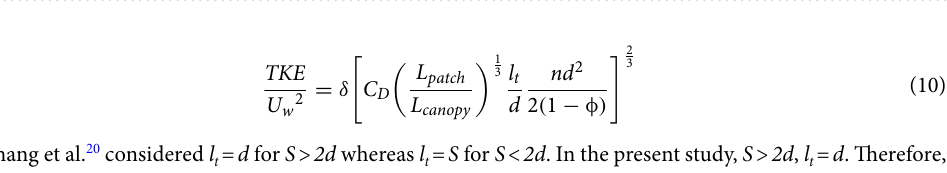
The parameter ϕ has been substituted by its definition to obtain two differentiated parameters (one related to patch length and the other to shoot density), as: